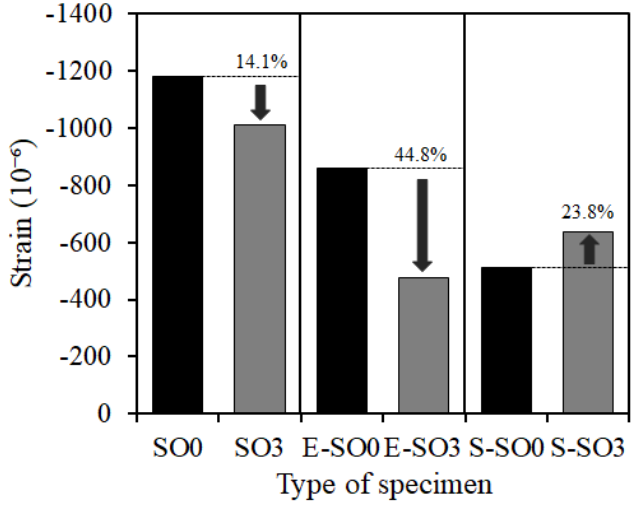
Figure 14. Shrinkage reduction effect of silicon oil in ECO-FRPCM.